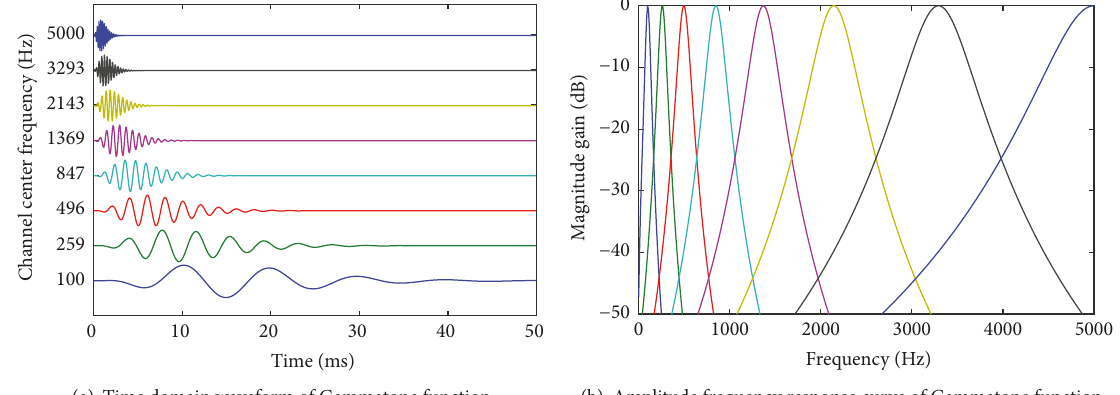
Figure 1: Gammatone filter bank.